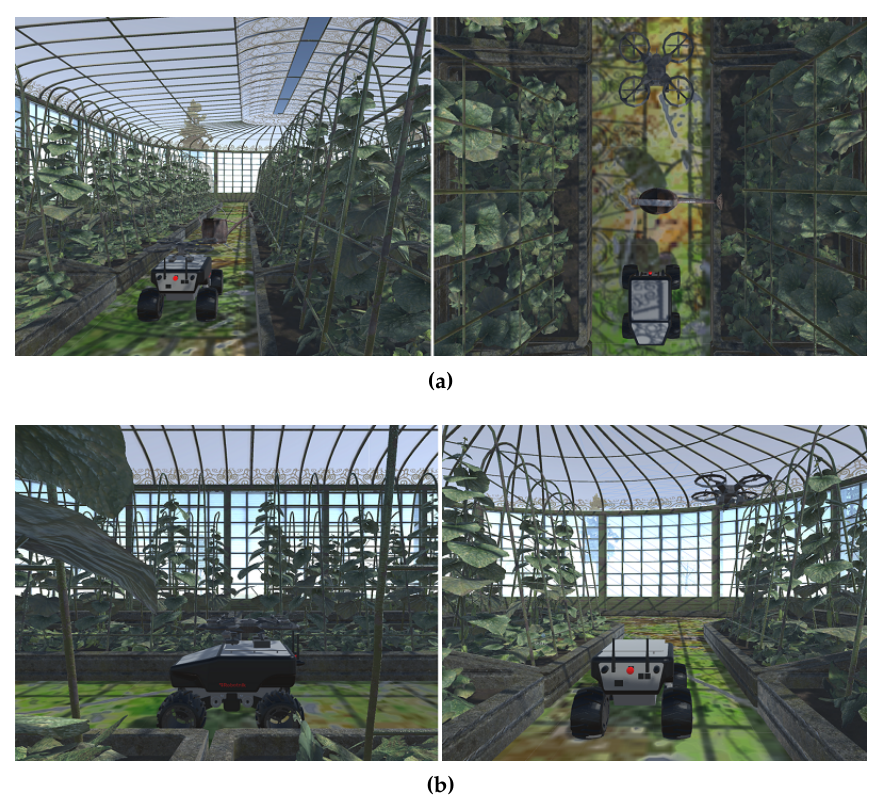
Figure 9. Two situations considered in the simulations: ( a ) The UGV cannot avoid an obstacle, so the UAV continues the route, and they meet again in the next corridor; ( b ) The UGV detects an anomaly in the environmental variables, and the UAV moves around looking for the